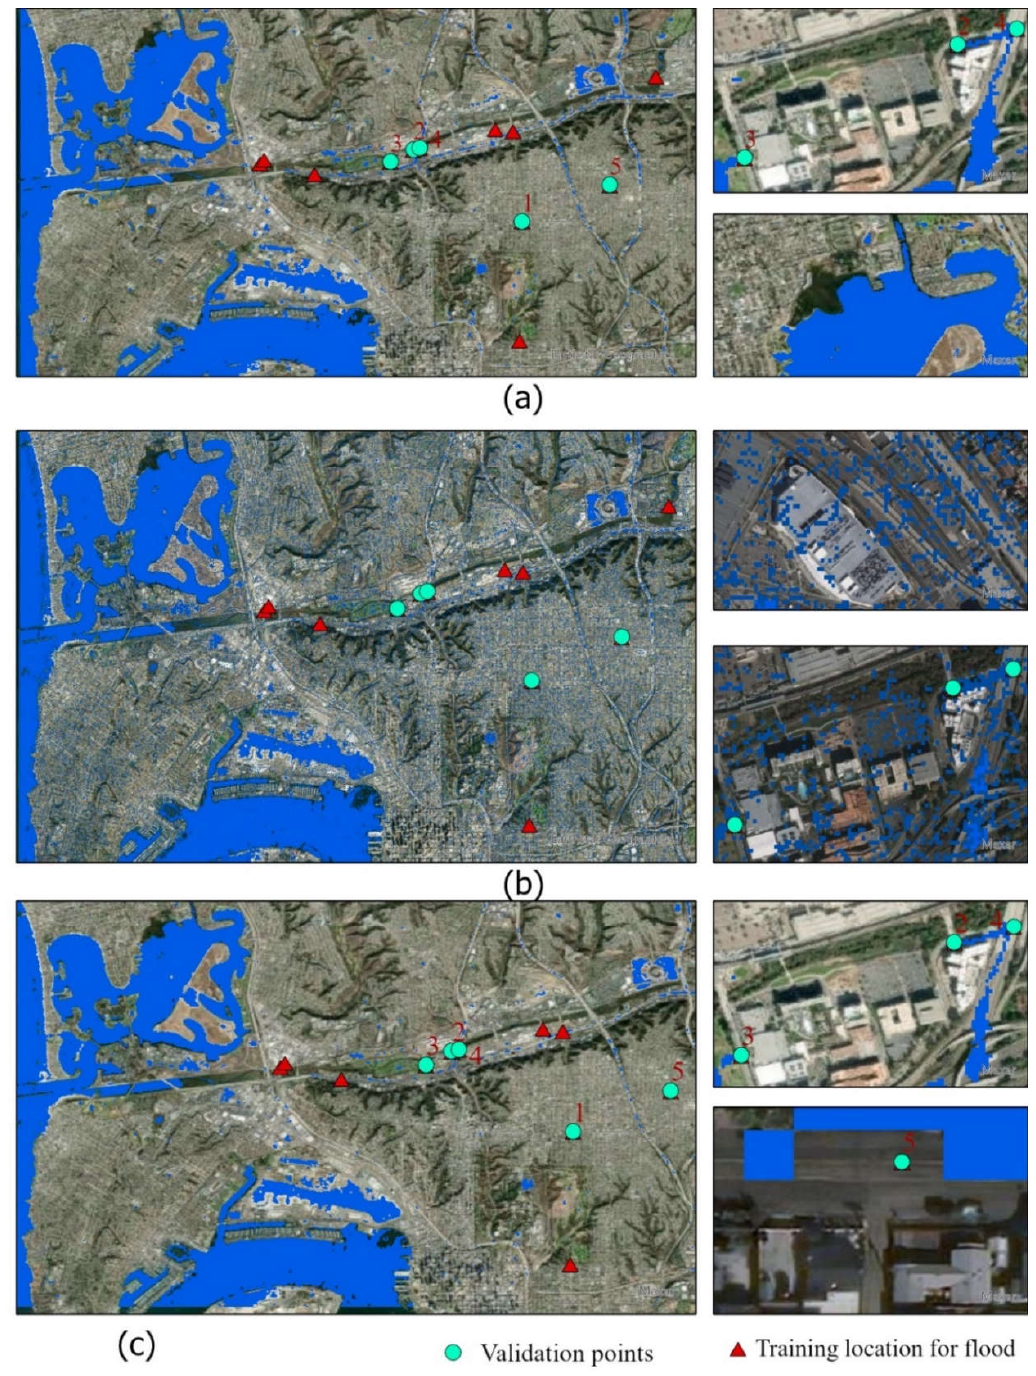
Figure 6. 2017 Flood image processing using ( a ) Maximum Likelihood Classifier, ( b ) Random Forest ( c ) Support Vector Machine.